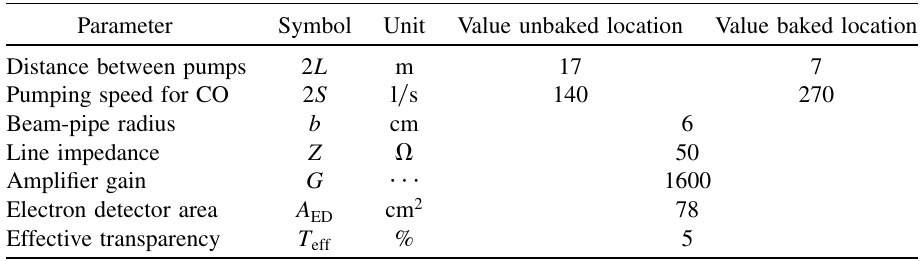
TABLE I. Parameters used to estimate the electron desorption coefficient for the baked and unbaked surface.